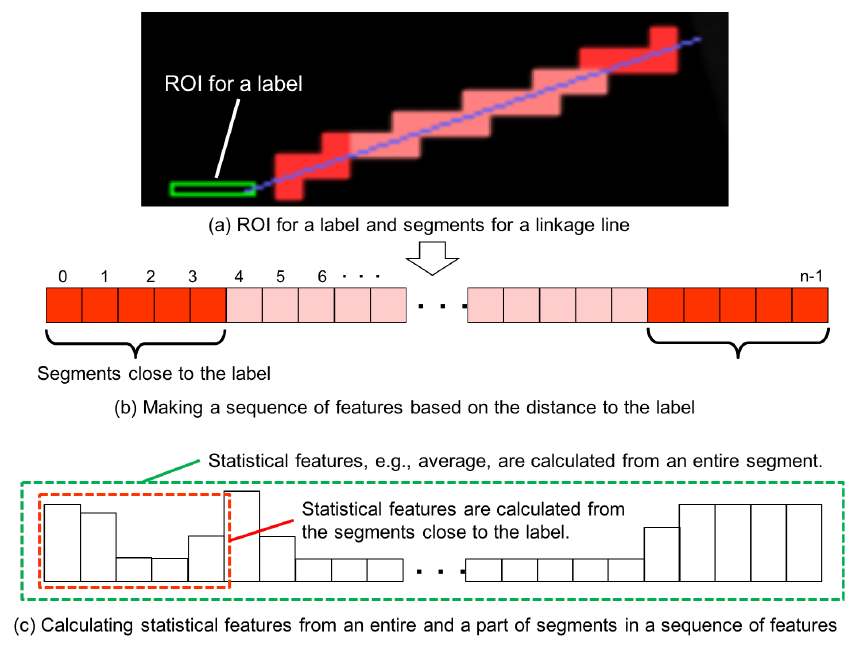
Figure 9. Definition of the features for a linkage